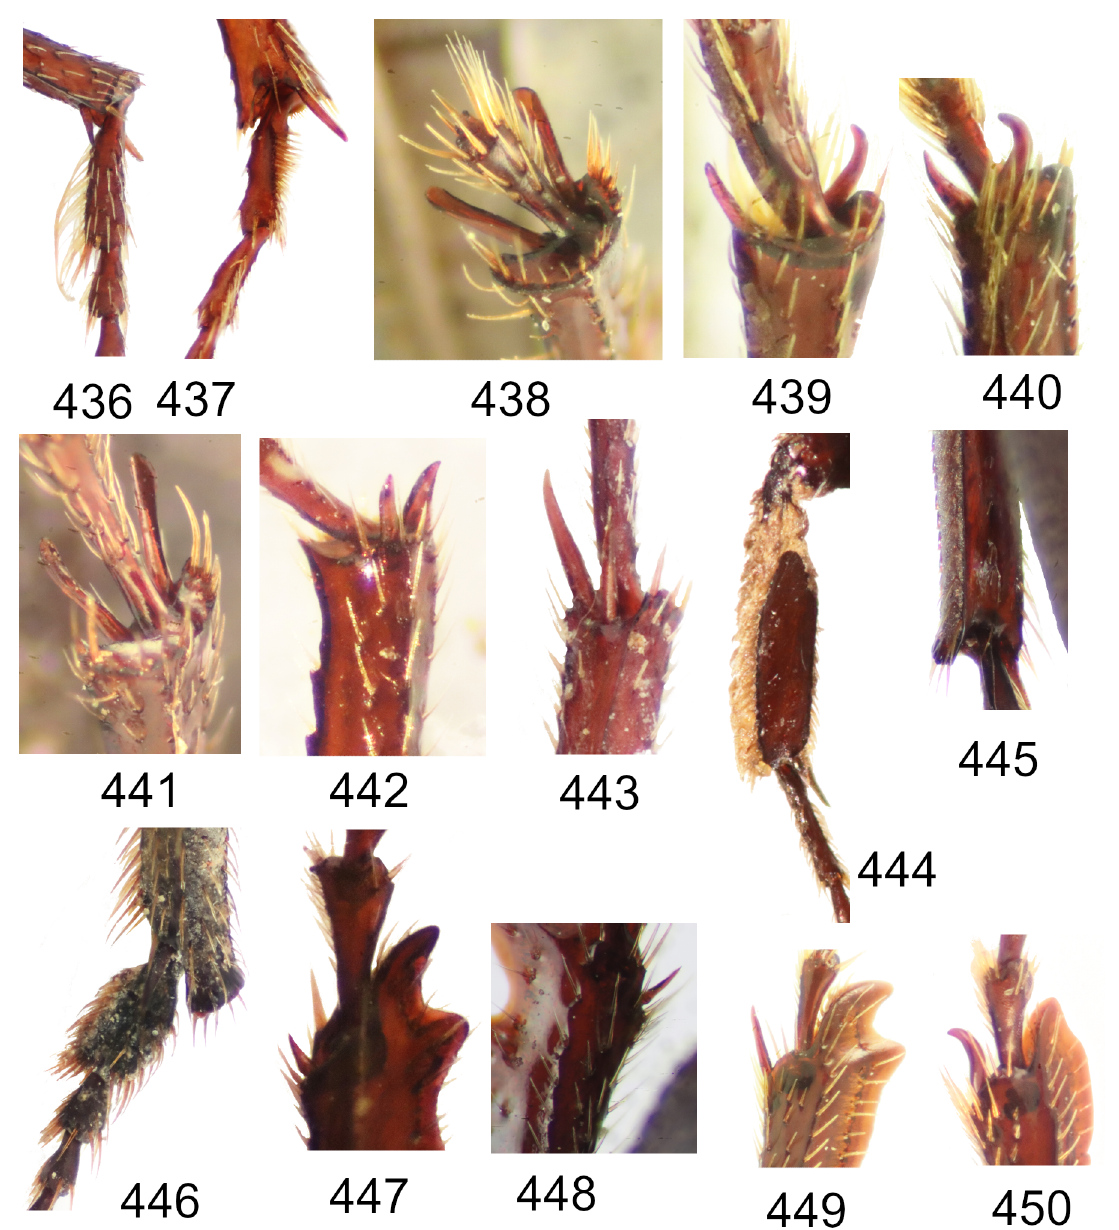
Figs 436–450. Papuan and Wallacean Maechidius Macleay, 1819, legs, various views. 436 . M. hirtipes Arrow, 1941, lectotype, ♂, basal metatarsomere (BMNH). 437 . M. tarsalis Arrow, 1941, lectotype, ♂, basal metatarsomere (BMNH). 438 . M. babyrousa sp. nov., paratype, ♀, metatibial terminal spurs (BMNH). 439 . Same, paratype, ♂ (BMNH). 440 . Same, different aspect (BMNH). 441 . M. yamdena sp. nov., paratype, ♀, metatibial terminal spurs (BMNH). 442 . Same, paratype, ♂ (BMNH). 443 . M. longipes sp. nov., holotype, ♂, metatibial terminal spurs (BMNH). 444 . M. ursus sp. nov., holotype, ♀, left metatibia and basal metatarsomere (NME). 445 . M. dani sp. nov., holotype, ♂, apical portion of metatibia (IECA). 446 . M. skalei sp. nov., holotype, ♂, apical portion of metatibia and basal metatarsomere (NME). 447 . M. yamdena sp. nov., paratype, ♂, protibial terminal spur (BMNH). 448 . Same, paratype, ♀ (BMNH). 449 . M. babyrousa sp. nov., paratype, ♀, protibial terminal spur (BMNH). 450 . Same, paratype, ♂ (BMNH). Not to